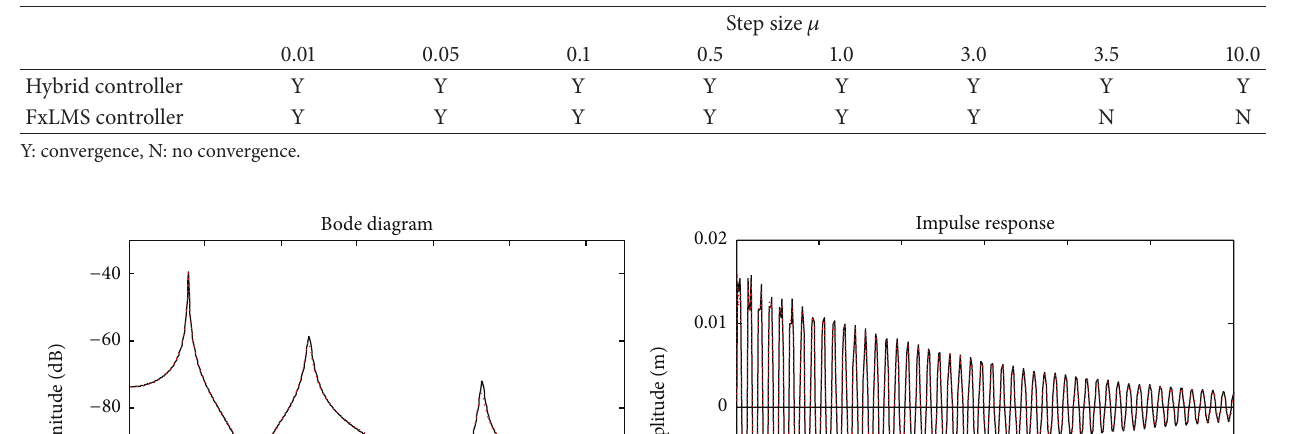
Table 2: The convergence situation for hybrid controller and FxLMS controller under different step sizes.